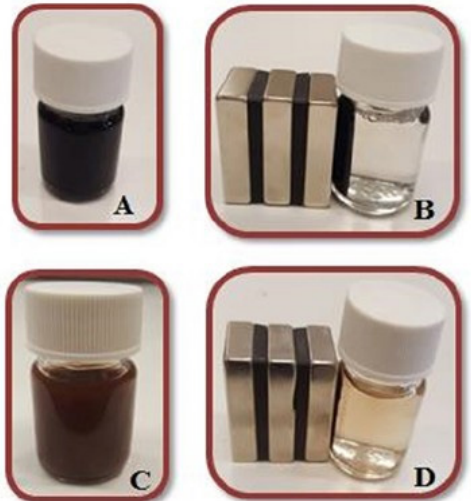
O particles before magnetic separation, B. Fe 3 4